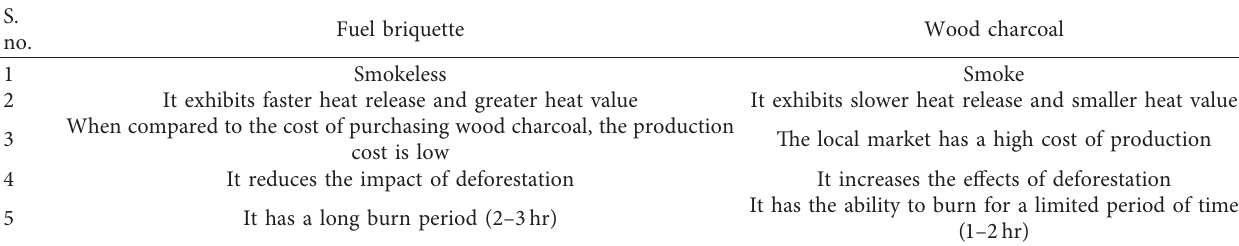
Figure 11: Effect of heating time on yield and quality of char. Table 5: Fuel briquette and wood charcoal comparison analysis [9, 14].